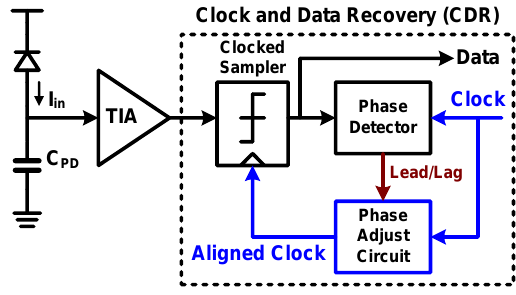
Figure 42. Simplified block diagram of a complete high-speed photodetecting receiver including CDR.